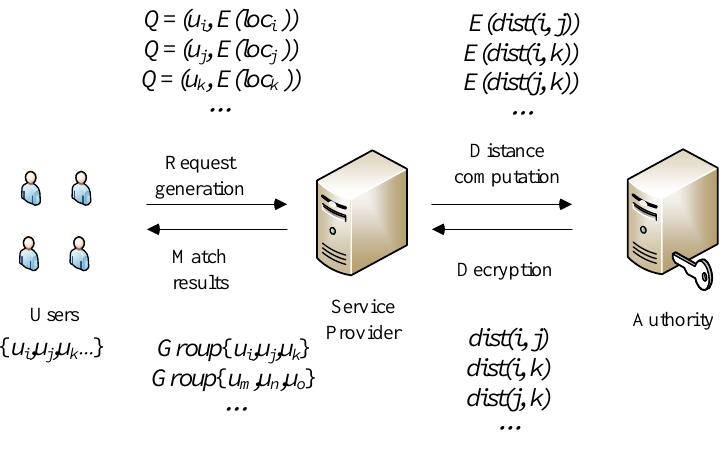
Figure 2. System